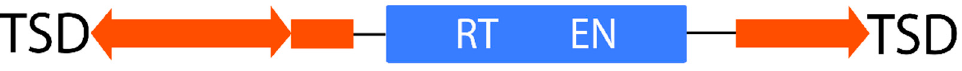
Figure 4. Structure of Penelope-like elements (PLEs).